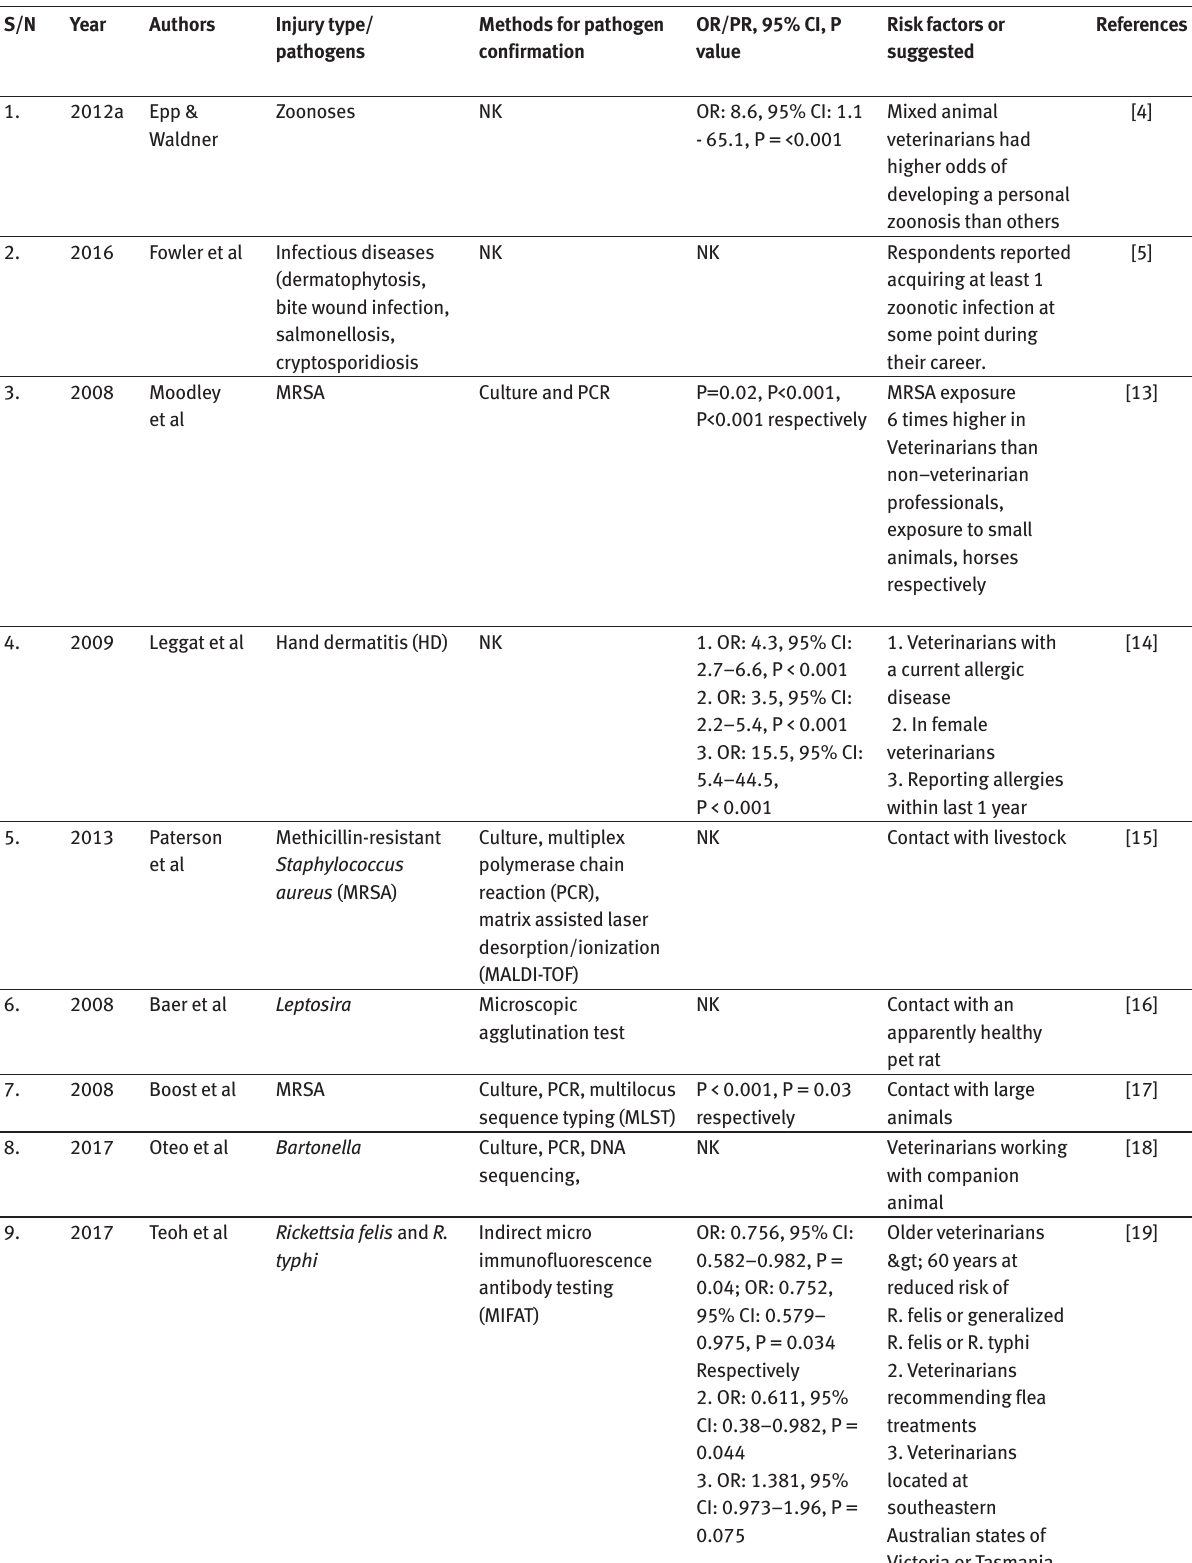
Table 3 A summary of biological hazards and the associated risk factors/practices identified for the systematic review